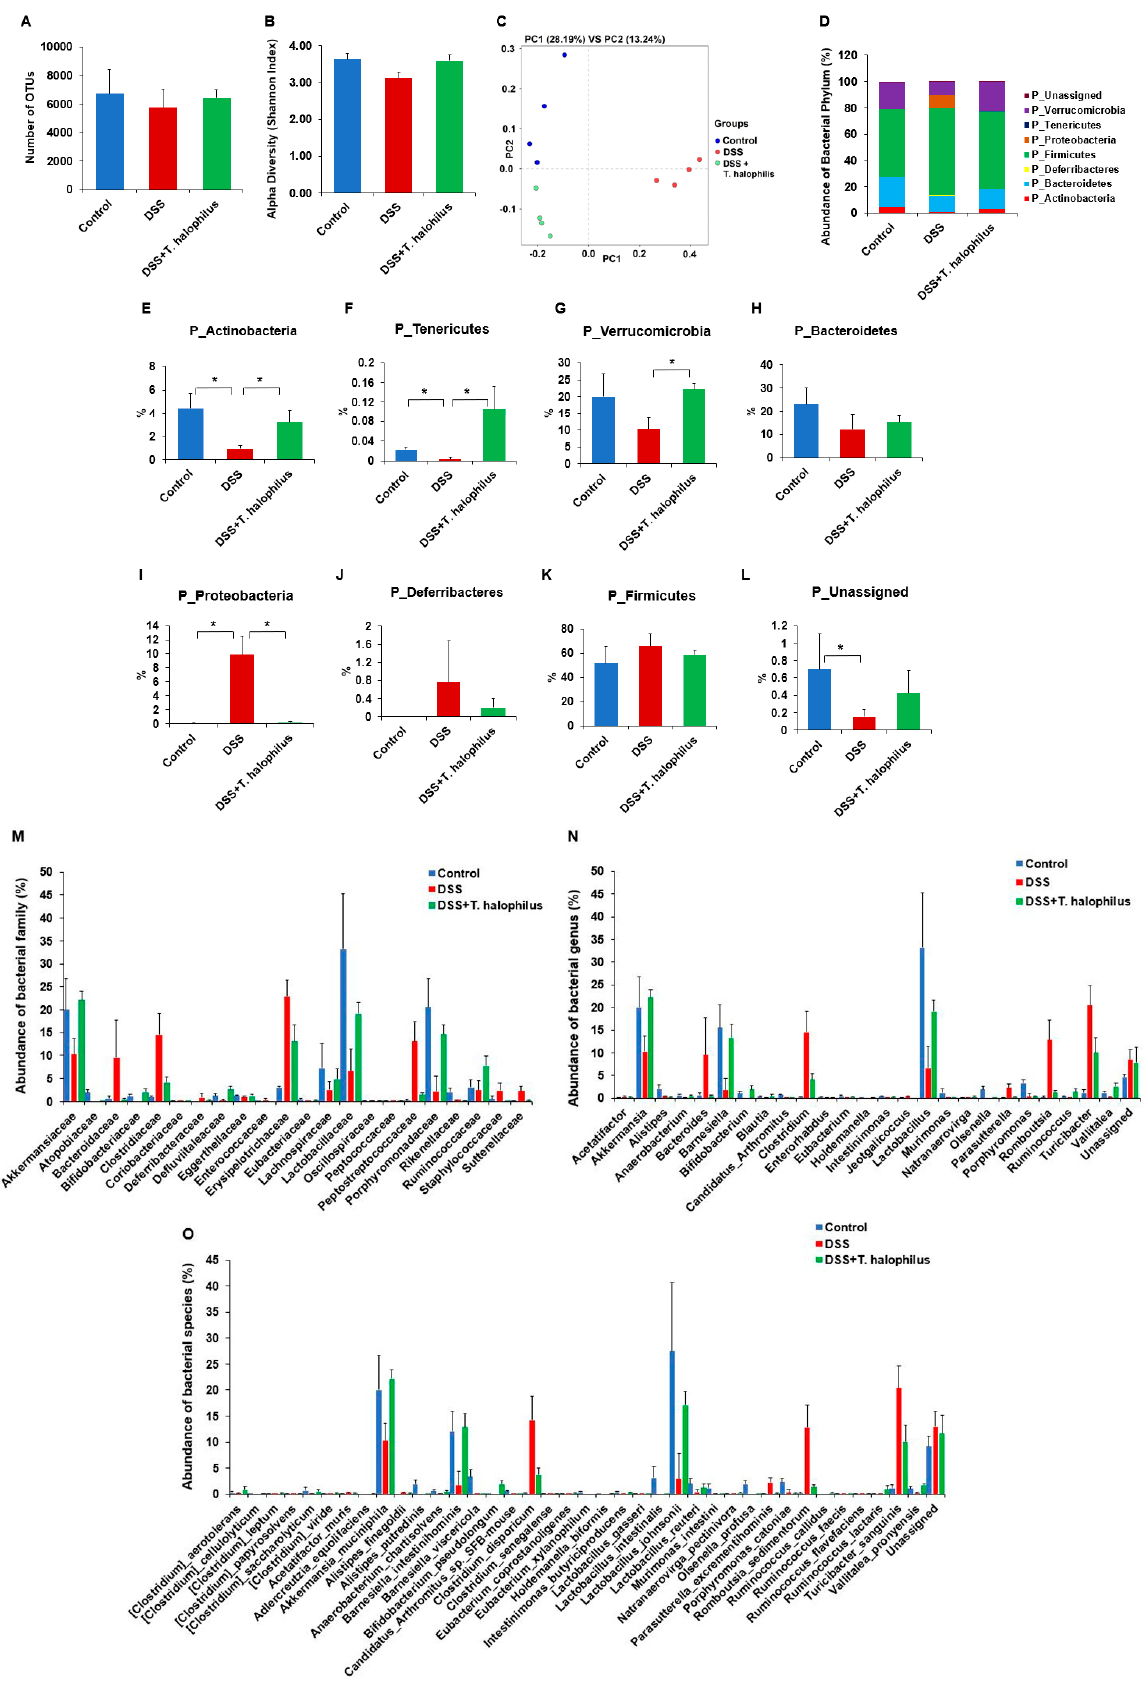
Figure 5. T. halophilus modulates gut microbiota compositions in DSS-induced colitis mice. Fecal samples were collected from normal control mice, 4% DSS-induced colitis mice, and colitis mice treated with T. halophilus. Microbiome analysis was performed using sequencing data of 16S rRNA V3 and V4 amplicons. ( A ) Operational Taxonomic Units (OTUs), ( B ) Alpha diversity (Shannon in- dex), and ( C ) Principal component analysis (PCA) plot. ( D – L ) Abundance of bacterial phyla. Abun- dance of bacterial ( M ) family, ( N ) genus, and ( O ) species showed significant differences among groups. Four mice were used in each experimental group. The Mann–Whitney U test was performed with GraphPad for statistical analysis. 3.7. T. halophilus Administration Affects Microbial Abundance in DSS-Induced Colitis at Family and Genus Levels At the family level, Bifidobacteriaceae ( p < 0.03), Defluviitaleaceae ( p < 0.03), Eubacteri- aceae ( p < 0.03), Lactobacillaceae ( p < 0.03), Porphyromonadaceae ( p < 0.03), and Rikenellaceae ( p < 0.03) showed significantly reduced abundance in colitis mice compared to normal con- trol mice (Figure 5M). Clostridiaceae ( p < 0.03), Erysipelotrichaceae ( p < 0.03), Peptostreptococ- caceae ( p < 0.03), and Sutterellaceae ( p < 0.03) showed increased abundance in colitis mice compared to normal controls (Figure 5M). T. halophilus administration to colitis mice in- creased Akkermansiaceae ( p < 0.03), Defluviitaleaceae ( p < 0.03), Eubacteriaceae ( p < 0.03), Lac- tobacillaceae ( p < 0.03), Porphyromonadaceae ( p < 0.03), and Ruminococcaceae ( p < 0.03), and reduced Clostridiaceae ( p < 0.03), Erysipelotrichaceae ( p < 0.03), Peptostreptococcaceae ( p < 0.03), Staphylococcaceae ( p < 0.03), and Sutterellaceae ( p < 0.03) (Figure 5M). At the genus level, colitis mice showed increased populations of Acetatifactor ( p < 0.03), Clostridium ( p < 0.03), Jeotgalicoccus ( p < 0.03), Parasutterella ( p < 0.03), Romboutsia ( p < 0.03), and Turicibacter ( p < 0.03), and reduced populations of Alistipes ( p < 0.03), Anaerobacterium ( p < 0.03), Barnesiella